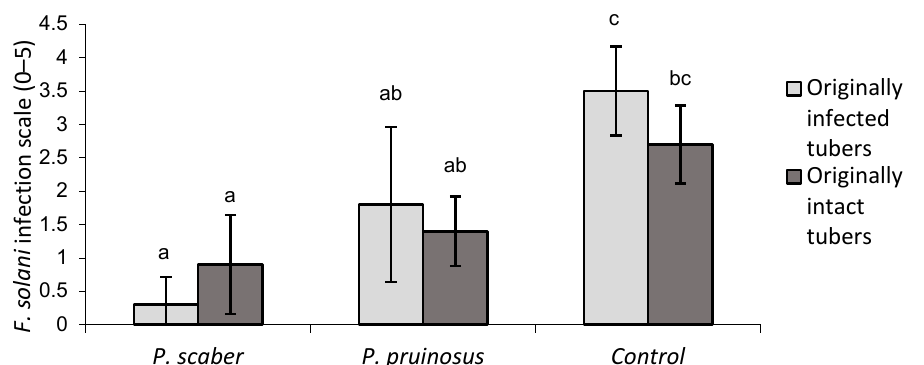
Figure 11. Effect of two isopod species ( Porcellio scaber , Porcellionides pruinosus ) on the spread of Fusarium solani on infected and on originally intact potato tubers (the same letters above the bars indicate the lack of a significant ( p ≤ 0.05) difference according to ANOVA with Tukey’s pairwise comparisons; error bar: CI 95%).